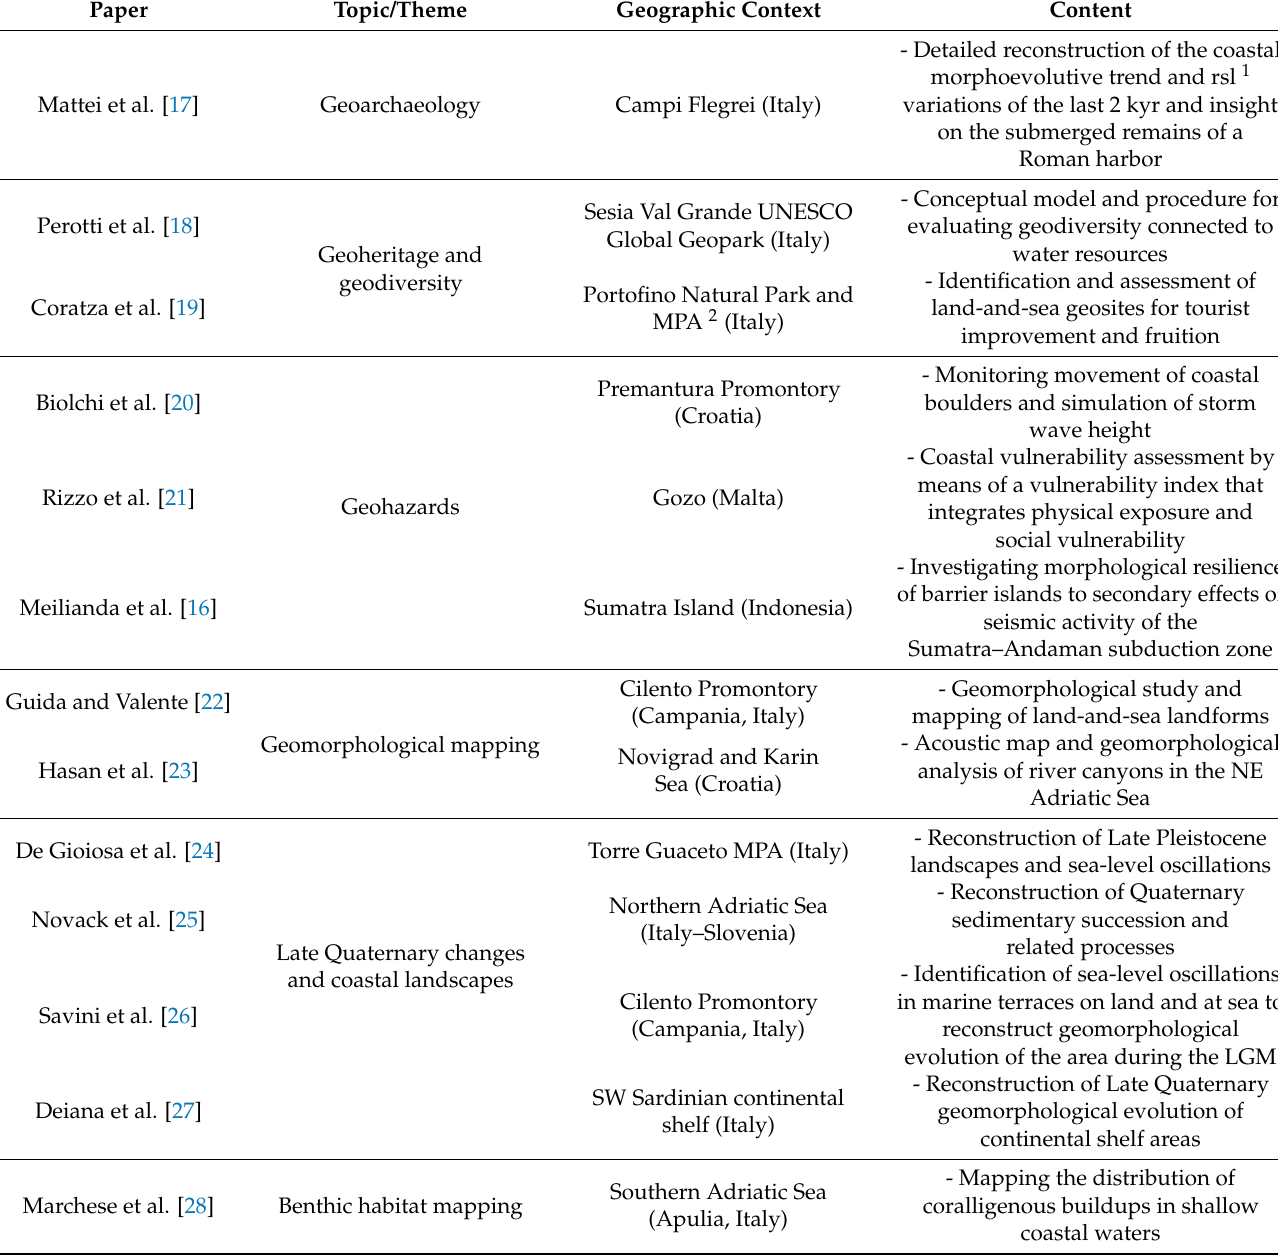
Table 1. Papers published in the Special Issue grouped according to their theme and